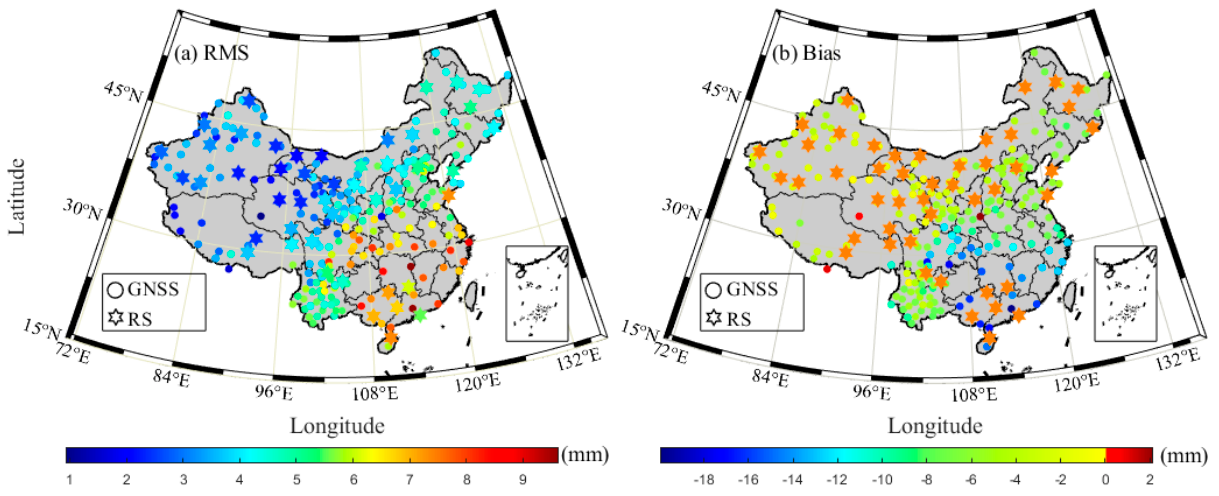
Figure 7. RMS and Bias distributions of PWV differences between FY-3A and GNSS/RS over the period of 2012 to 2013. Table 4. Statistical results of RMS, Bias, MAE of PWV differences between FY3-A and GNSS (260)/RS (87), respectively, in China over the period of 2012 to 2013.